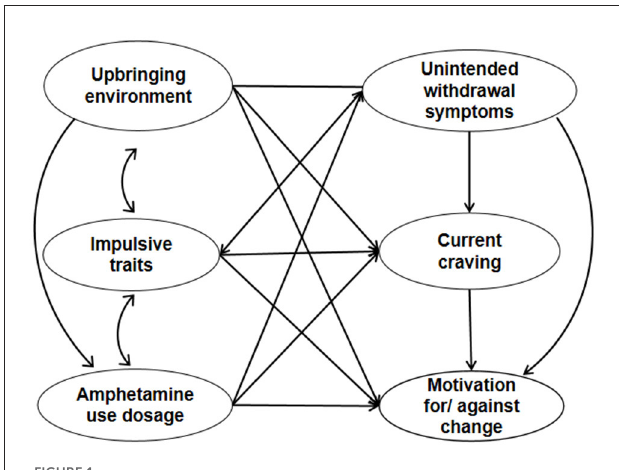
FIGURE1 Conceptual model of the relationship of motivation with the upbringing environment, impulsivity traits, and drug